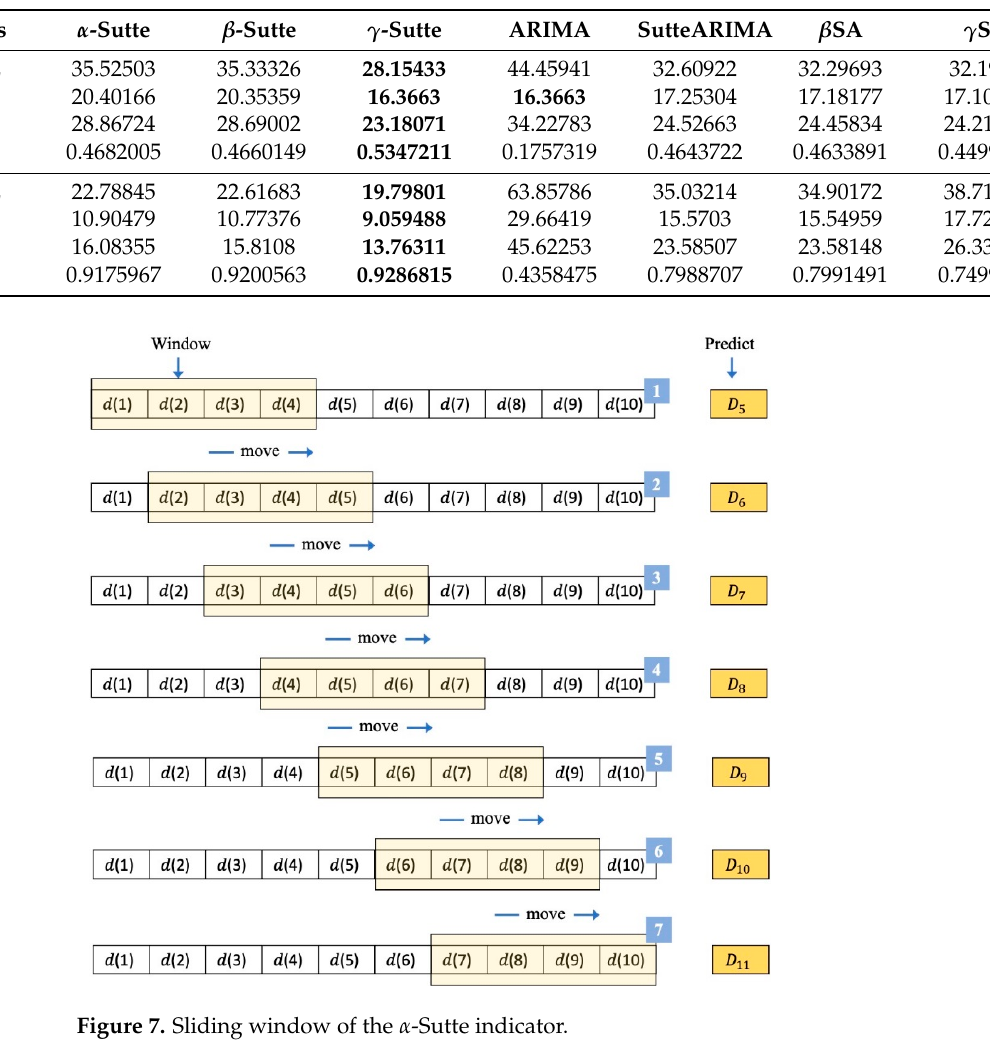
Table 7. The prediction results of the time series and ensemble models in two regions.